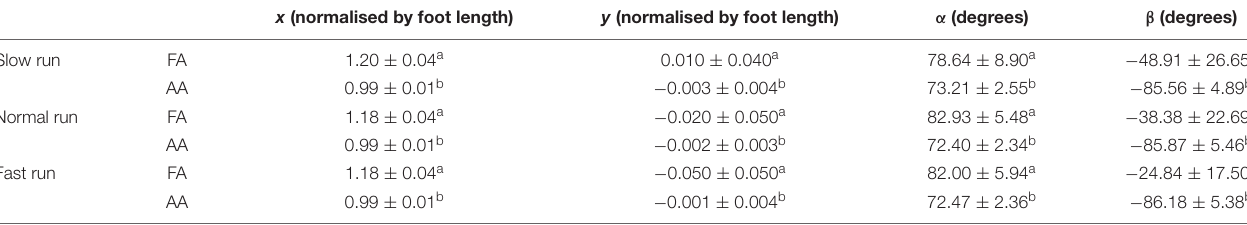
TABLE 1 | Statistical analysis of the 3D orientation and position differences between the FA and AA of the MP joint during running. x (normalised by foot length) y (normalised by foot length) α (degrees) β (degrees) Slow run FA